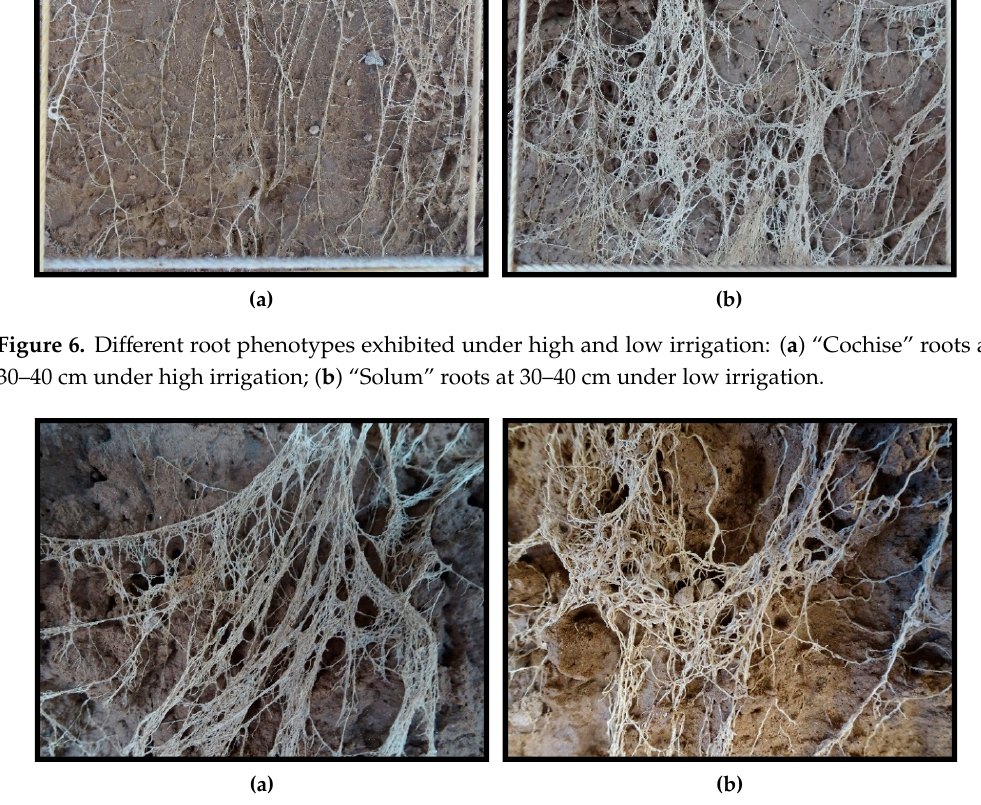
Figure 7. Webbed root phenotype under low irrigation seen at higher magnification: ( a ) “Solar” roots at 50–60 cm; ( b ) “Kopious” roots at 30–40 cm.